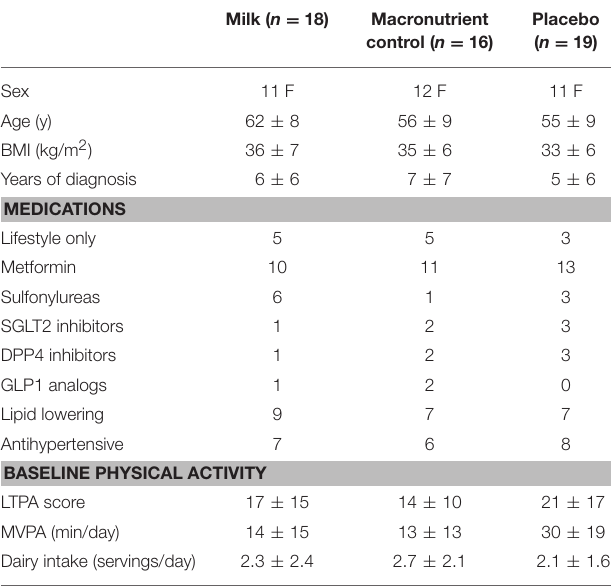
TABLE 1 | Baseline characteristics of